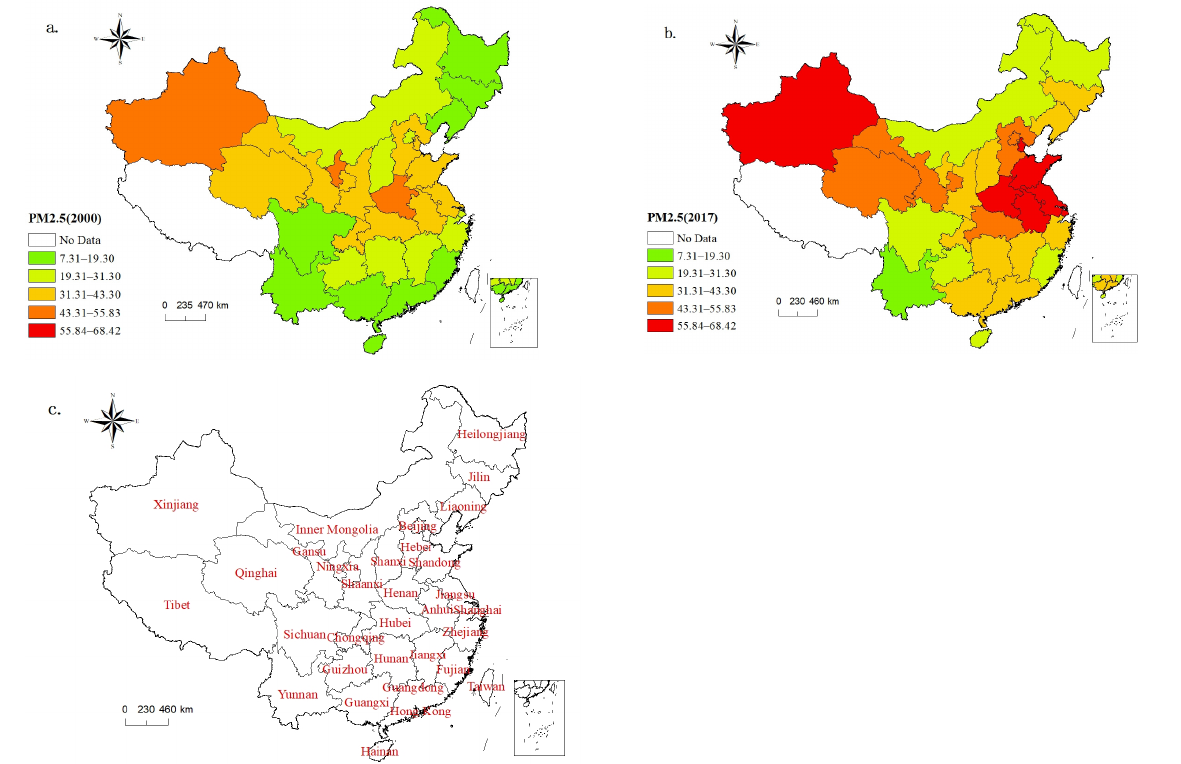
Figure 1. The temporal and spatial distribution of haze pollution (PM 2.5 ( µ g/m 3 )) in China’s provinces: ( a ) spatial distribution of haze pollution in 2000; ( b ) spatial distribution of haze pollution in 2017; ( c ) a map of China’s provincial administrative districts.